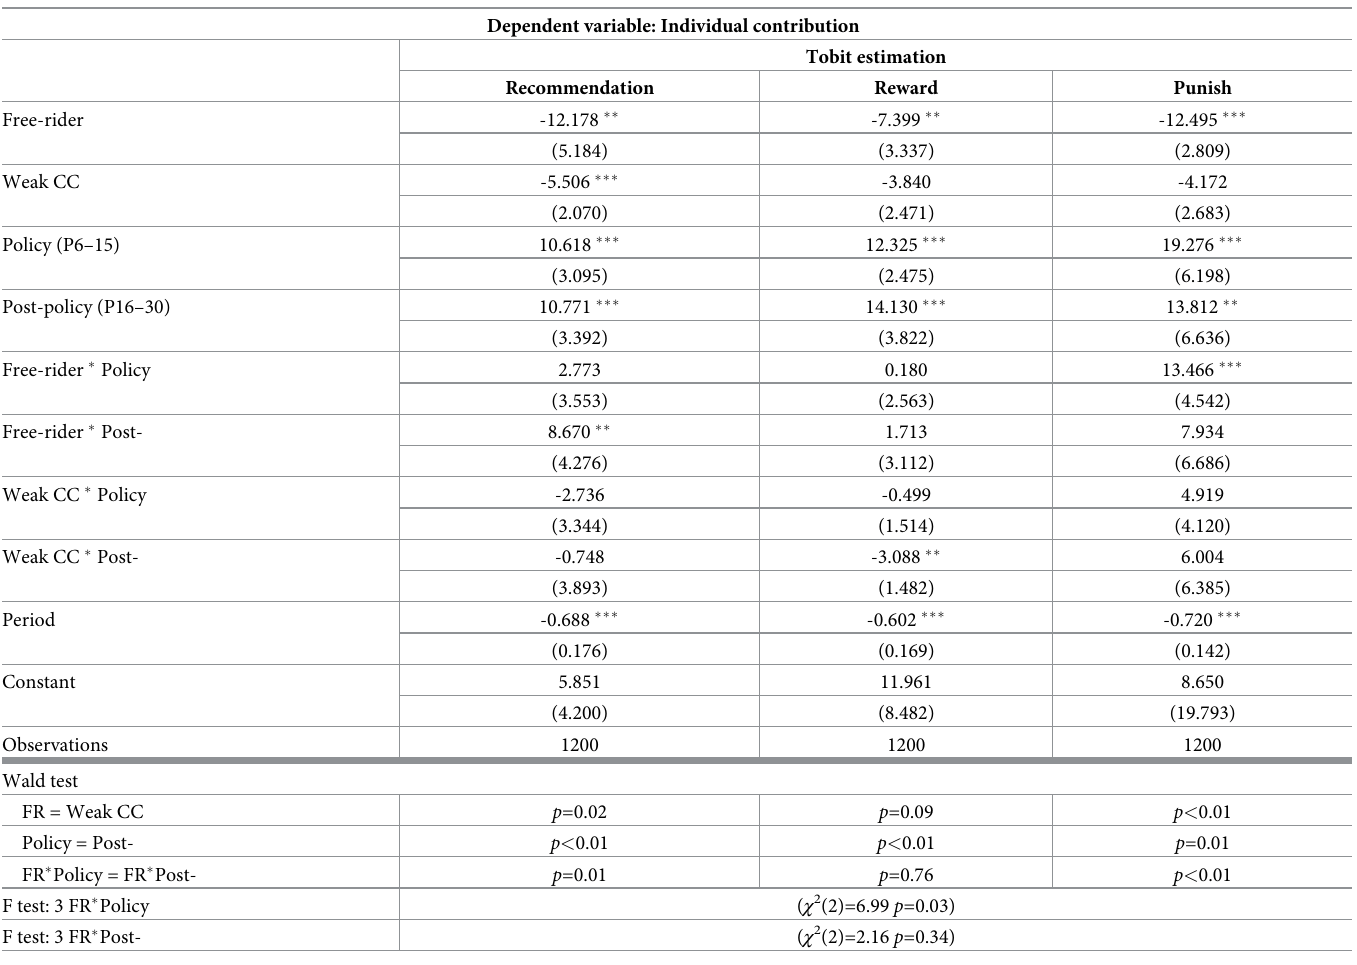
Table 6. Determinants of individual